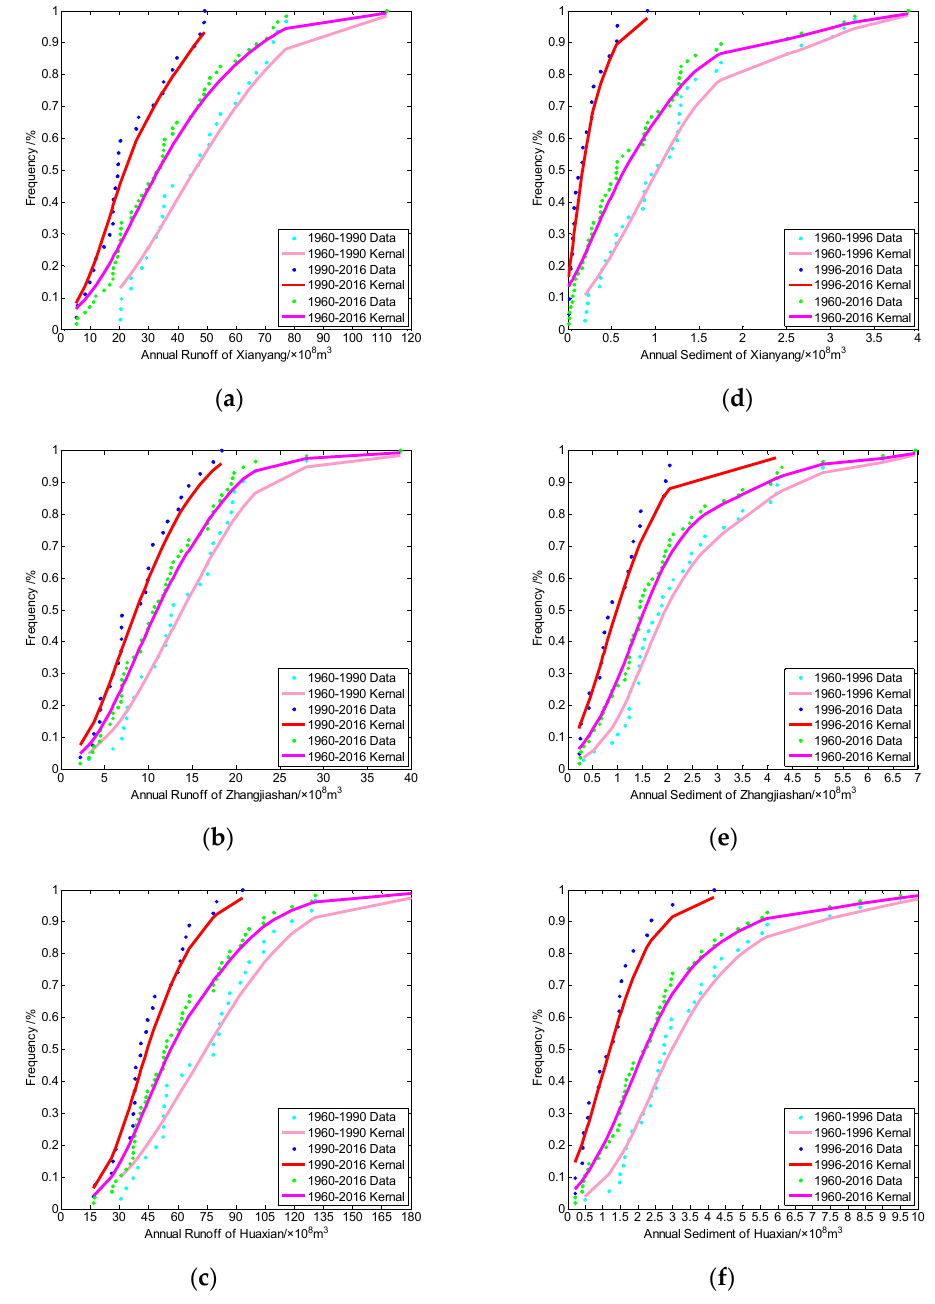
Figure 4. The marginal distribution function diagram of annual runoff and sediment yield of the Three Stations: ( a ) Runoff of Xianyang Station. ( b ) Runoff of Zhangjiashan Station. ( c ) Runoff of Huaxian Station. ( d ) Sediment of Xianyang Station. ( e ) Sediment of Zhangjiashan Station. ( f ) Sediment of Huaxian Station.